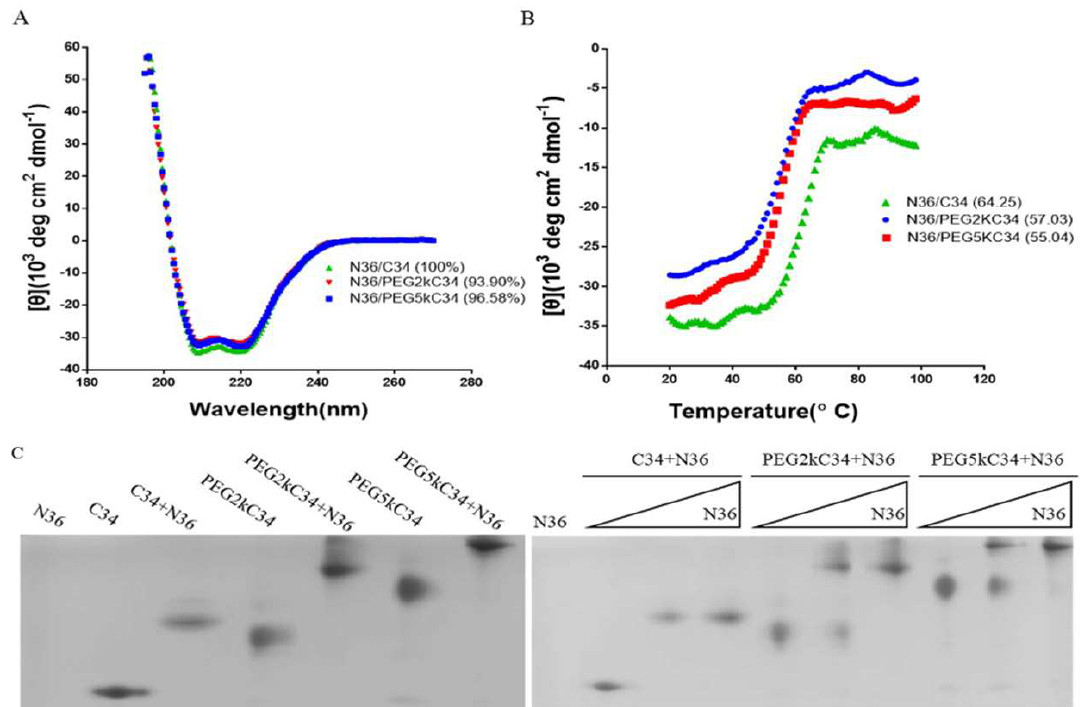
Figure 2. Analysis of the affinity of N36 and the designed peptides by CD spectroscopy and N-PAGE. ( A ) The α -helical content was calculated from the CD signal by dividing the mean residue ellipticity at 222 nm. ( B ) The midpoint of the thermal unfolding transition of the peptides. ( C ) N-PAGE analysis of 6-HB formation between N36 and C34 as well as PEGylated C34 peptides. The final concentration of the peptides N36, C34, PEG2kC34 and PEG5kC34 was 100 µ M. The gradient concentration of the peptides N36 on the right Figure 2C was 0, 50 and 100 µ M, respectively.